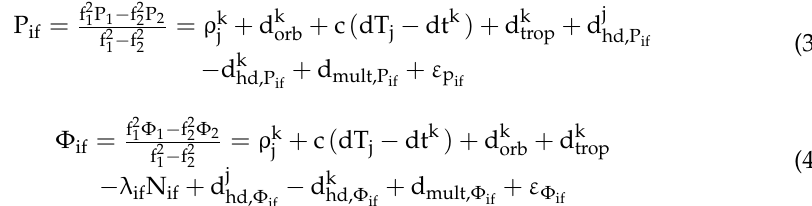
( b ) Figure 2. GNSS receivers used: ( a ) geodetic order receiver; ( b ) low-cost GNSS receiver. The low-cost GNSS receiver ZED-F9P of the U-Blox series was used for generating the observations (Figure 3a). This low-cost GNSS receiver had 184 channels on the fre- quencies of GPS: L1C/A, L2C; GLO: L1OF L2OF; GAL: E1B/C, E5b; and BDS: B1I, B2I sig- nals. A convergence time RTK < 10 s, cold start of 24 s and reacquisition time of 2 s were used, along with a navigation and tracking sensibility of 167 dBm, cold start of − 148 dBm and hot start of − 157 dBm. This was used with a SMA multiband antenna ANN-MB (Fig- ure 3b). ( a ) ( b ) Figure 3. Equipment used: ( a ) low-cost GNSS receiver; ( b ) U-Blox antenna.